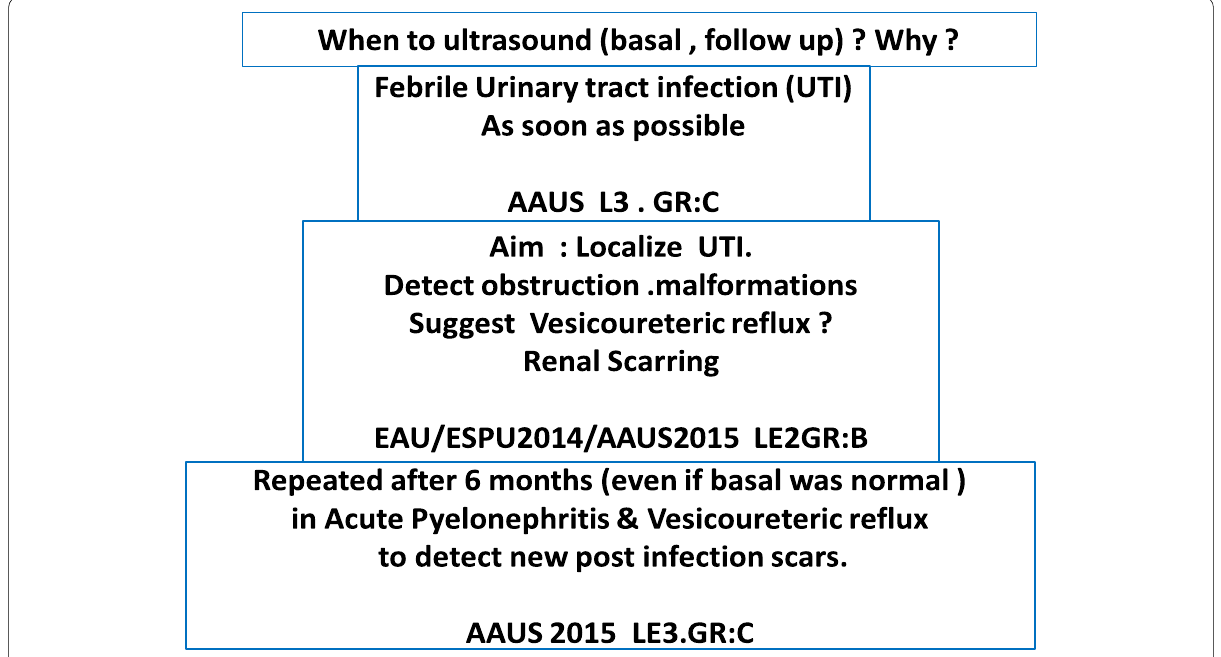
Fig. 3 National guideline. When and why to